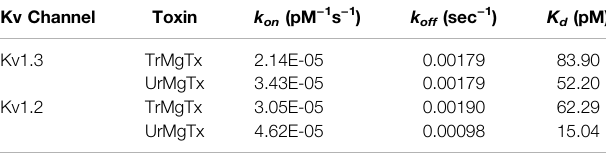
TABLE 2 | Kinetic parameters of rMgTx and Kv channel interaction. Kv